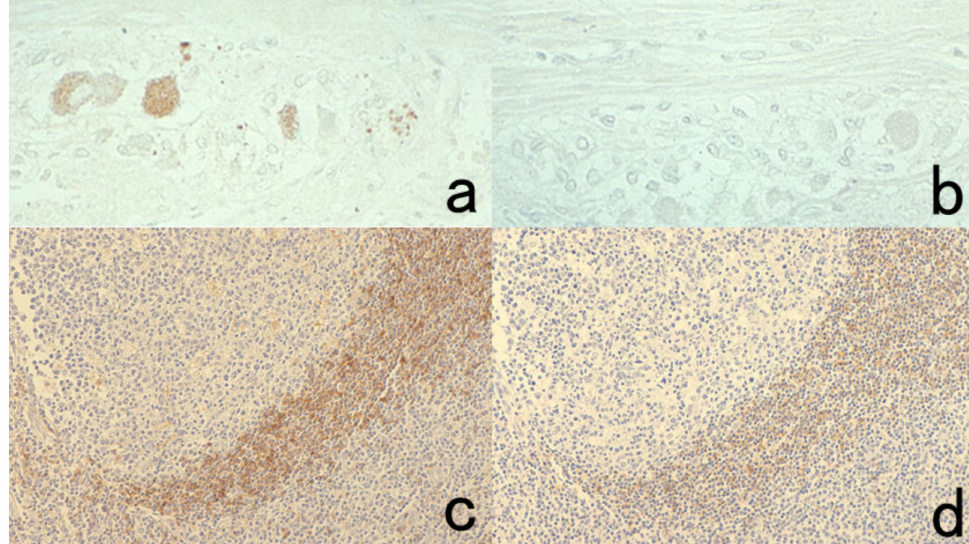
Figure 32. Deterioration of antigenicity by protease pretreatment. Top panels ( a , b ): substance P in the myenteric plexus of the small bowel. Bottom panels ( c , d ): IgD in the mantle zone of the pharyngeal tonsil. Left ( a , c ): without treatment and Right ( b , d ): after trypsin digestion for 15 min. Immunoreac- tivities of substance P and IgD are lost or markedly decreased by the enzymatic